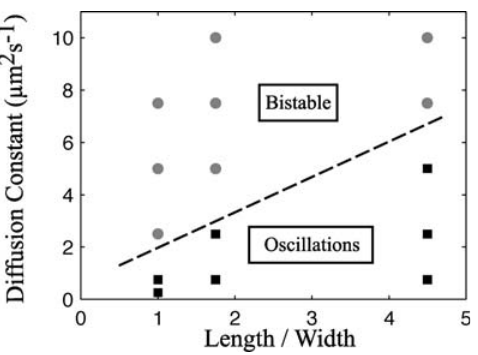
Figure 7. Bistability Diagram for Different Diffusion Constants and Cell Geometries The mean-field model was solved for three different geometries: Spherical mutant (length/width ¼ 1), wt (length/width ¼ 4.5), and an intermediate geometry (length/width ¼ 1.75; cylinder of radius 1 l m and length 1.5 l m padded with half spheres of radius 1 l m). The combinations indicated with black squares display oscillations when started from the initial condition in which 3/4 of the MinD molecules are started in one half of the cell and 1/4 started in the other. The gray circles represent combinations that display bistability: When the simulation is started from the initial condition described above, the system will go to a stationary homogeneous state. When the simulation is started from an existing MinD accumulation at one of the poles, it will start oscillating. DOI: 10.1371/journal.pcbi.0020080.g007